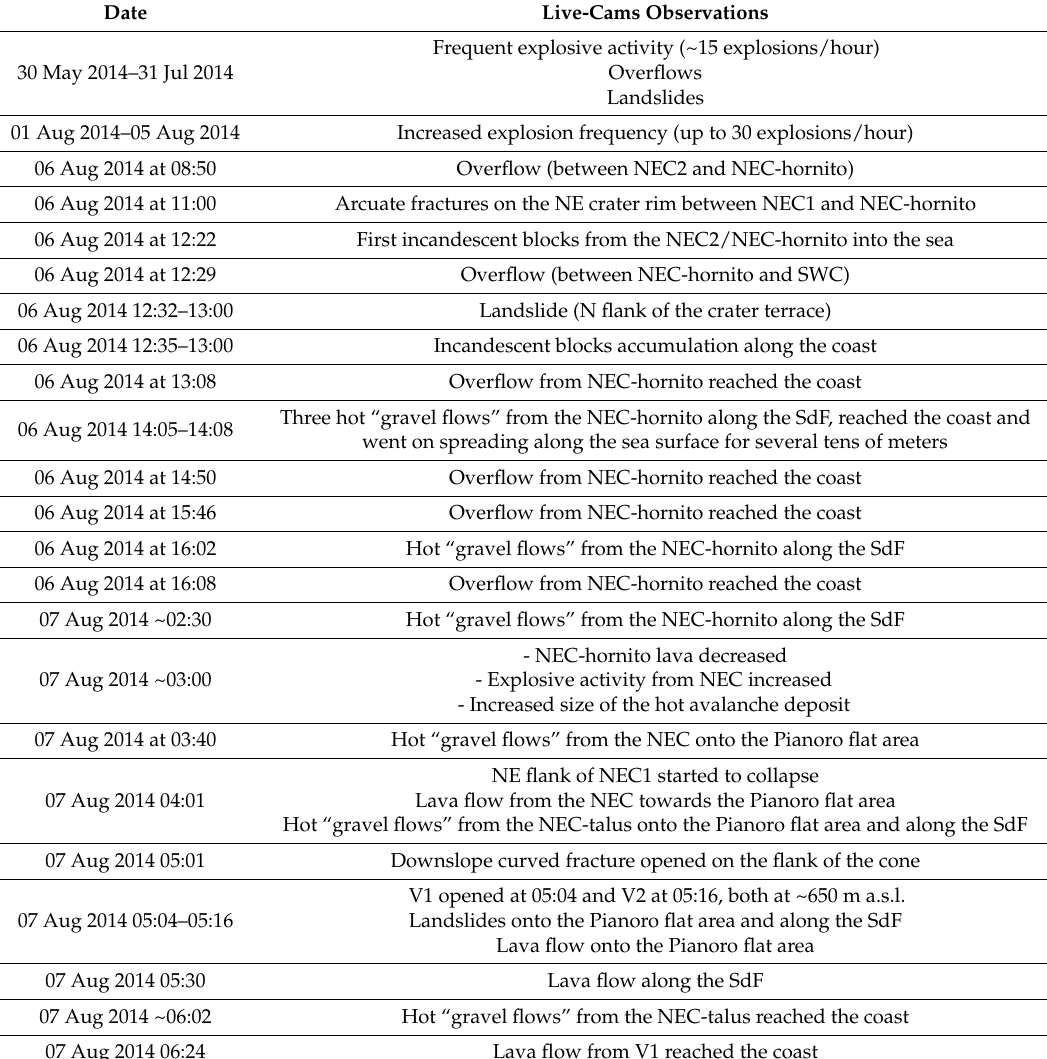
Table 1. Summary of the eruptive activity during the run-up and onset phases of the 2014 flank eruption, as derived from the camera monitoring